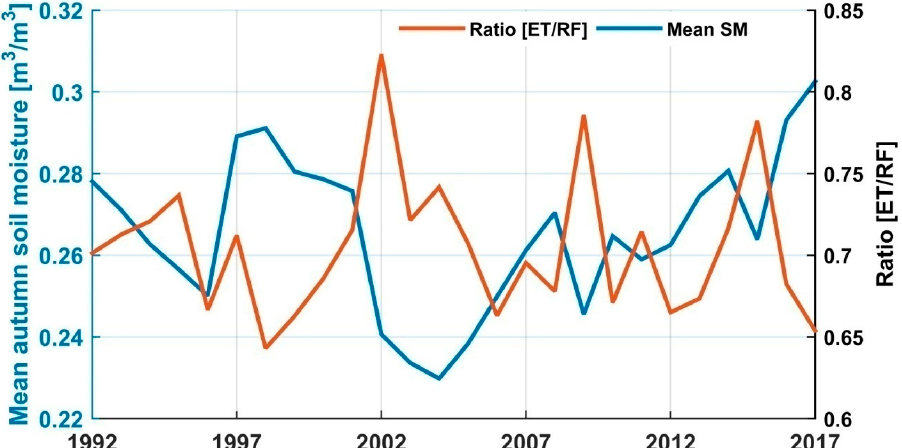
Figure 16. The effects of annual rainfall (RF) and evapotranspiration (ET) (expressed as ET/RF ratio) on the temporal distribution of autumn soil moisture over the UBNB from 1992 to 2017. We can see the highest ET/RF values over the known drought periods of 2002, 2009, and 2015 in the UBNB, as well as in Ethiopia in general [76].